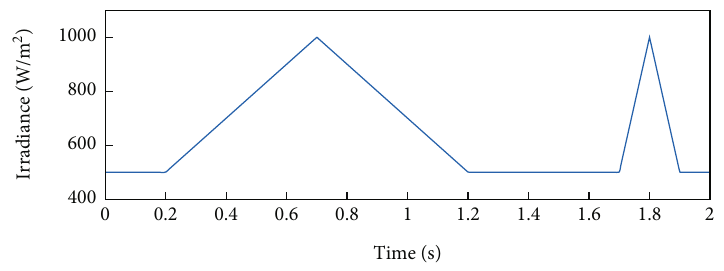
Figure 17: EN 50530 irradiance test pro fi